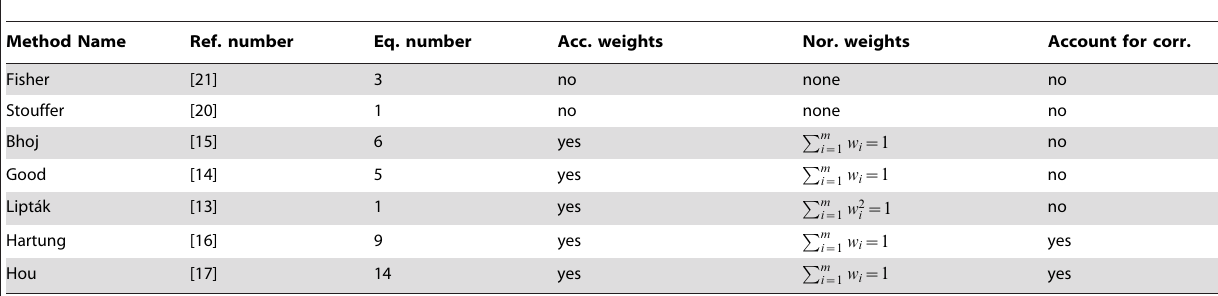
Table 1. Breakdown of Methods Used to Combine P -values Investigated.